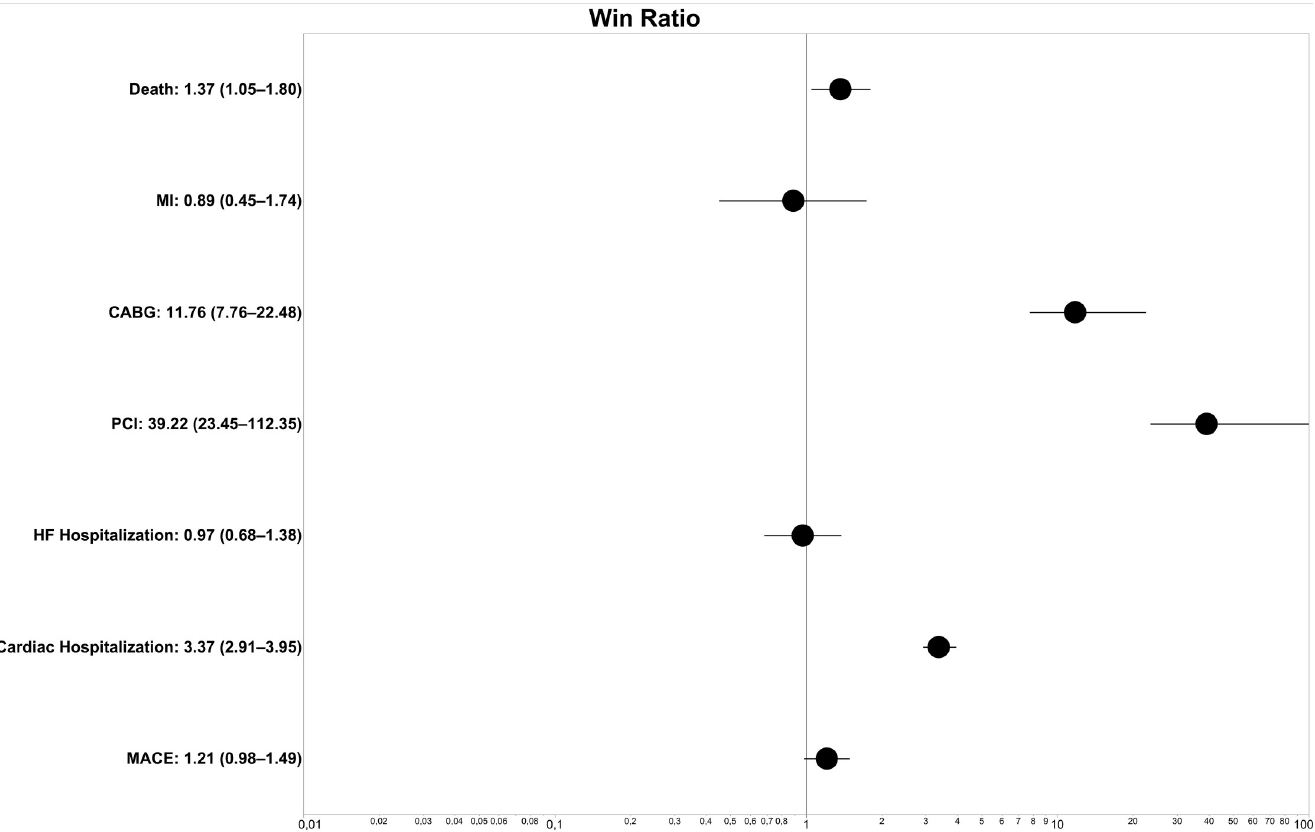
Fig 2. Forest plot of win ratio (with 95% confidence intervals) for propensity score matched pairs of patients with ACS INOCA and ACS OCAD. ACS: acute coronary syndrome, INOCA: myocardial ischemia with no obstructive coronary arteries, OCAD: obstructive coronary artery disease, MI: myocardial infarction, HF: heart failure, PCI: percutaneous coronary intervention, CABG: coronary artery bypass graft surgery.